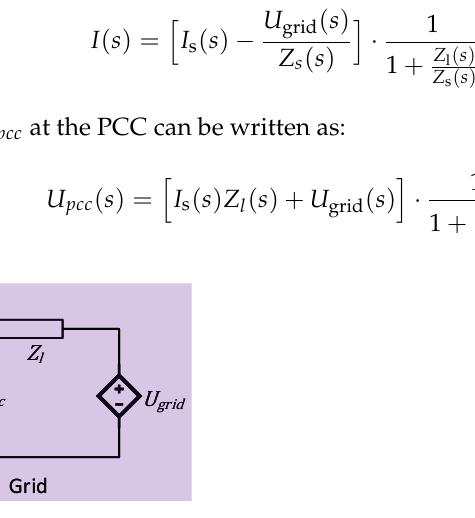
Figure 3. Small signal representation of source-grid